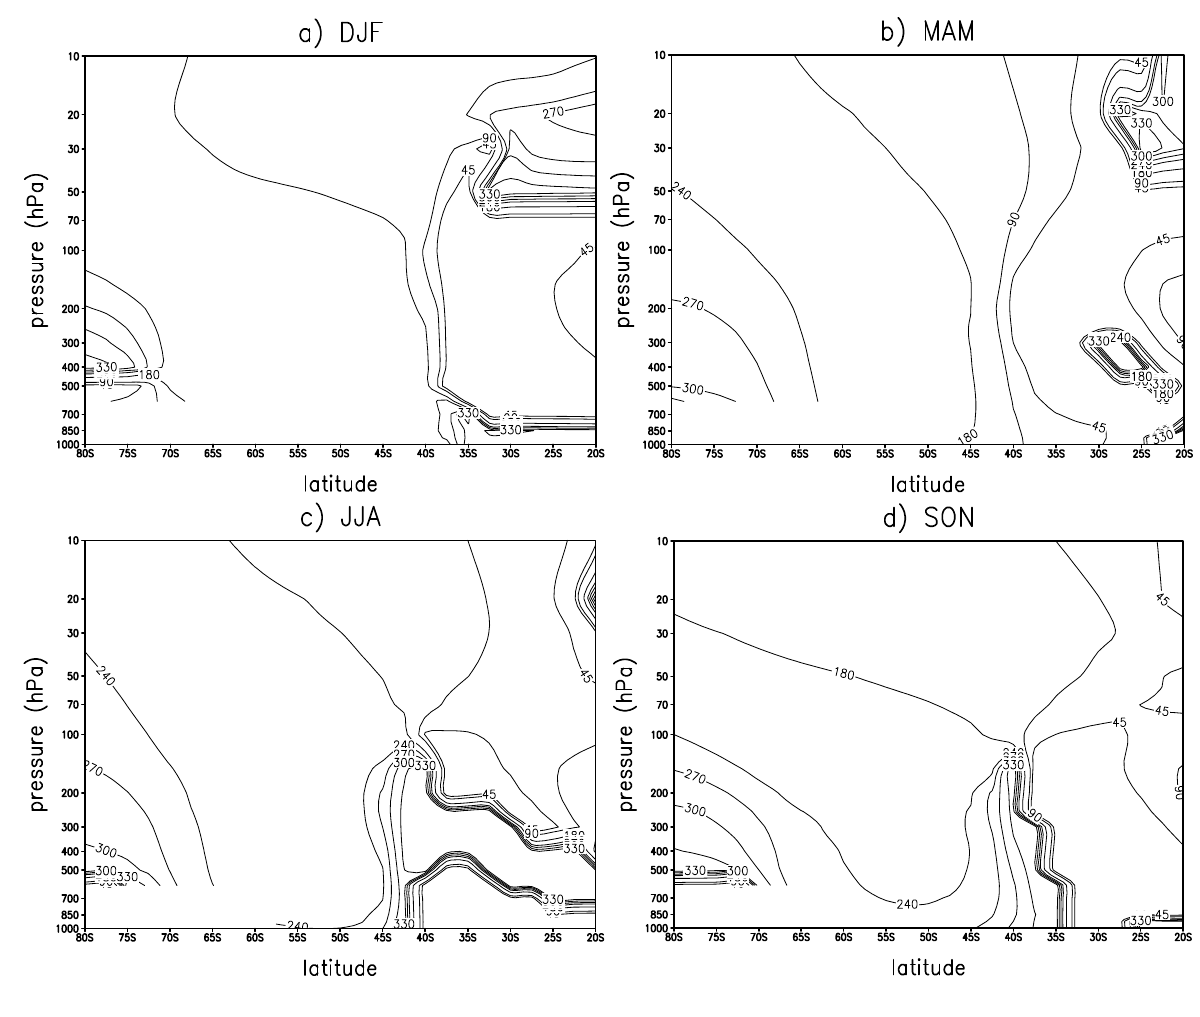
Fig. 2. Same as Fig 1, but for the phase